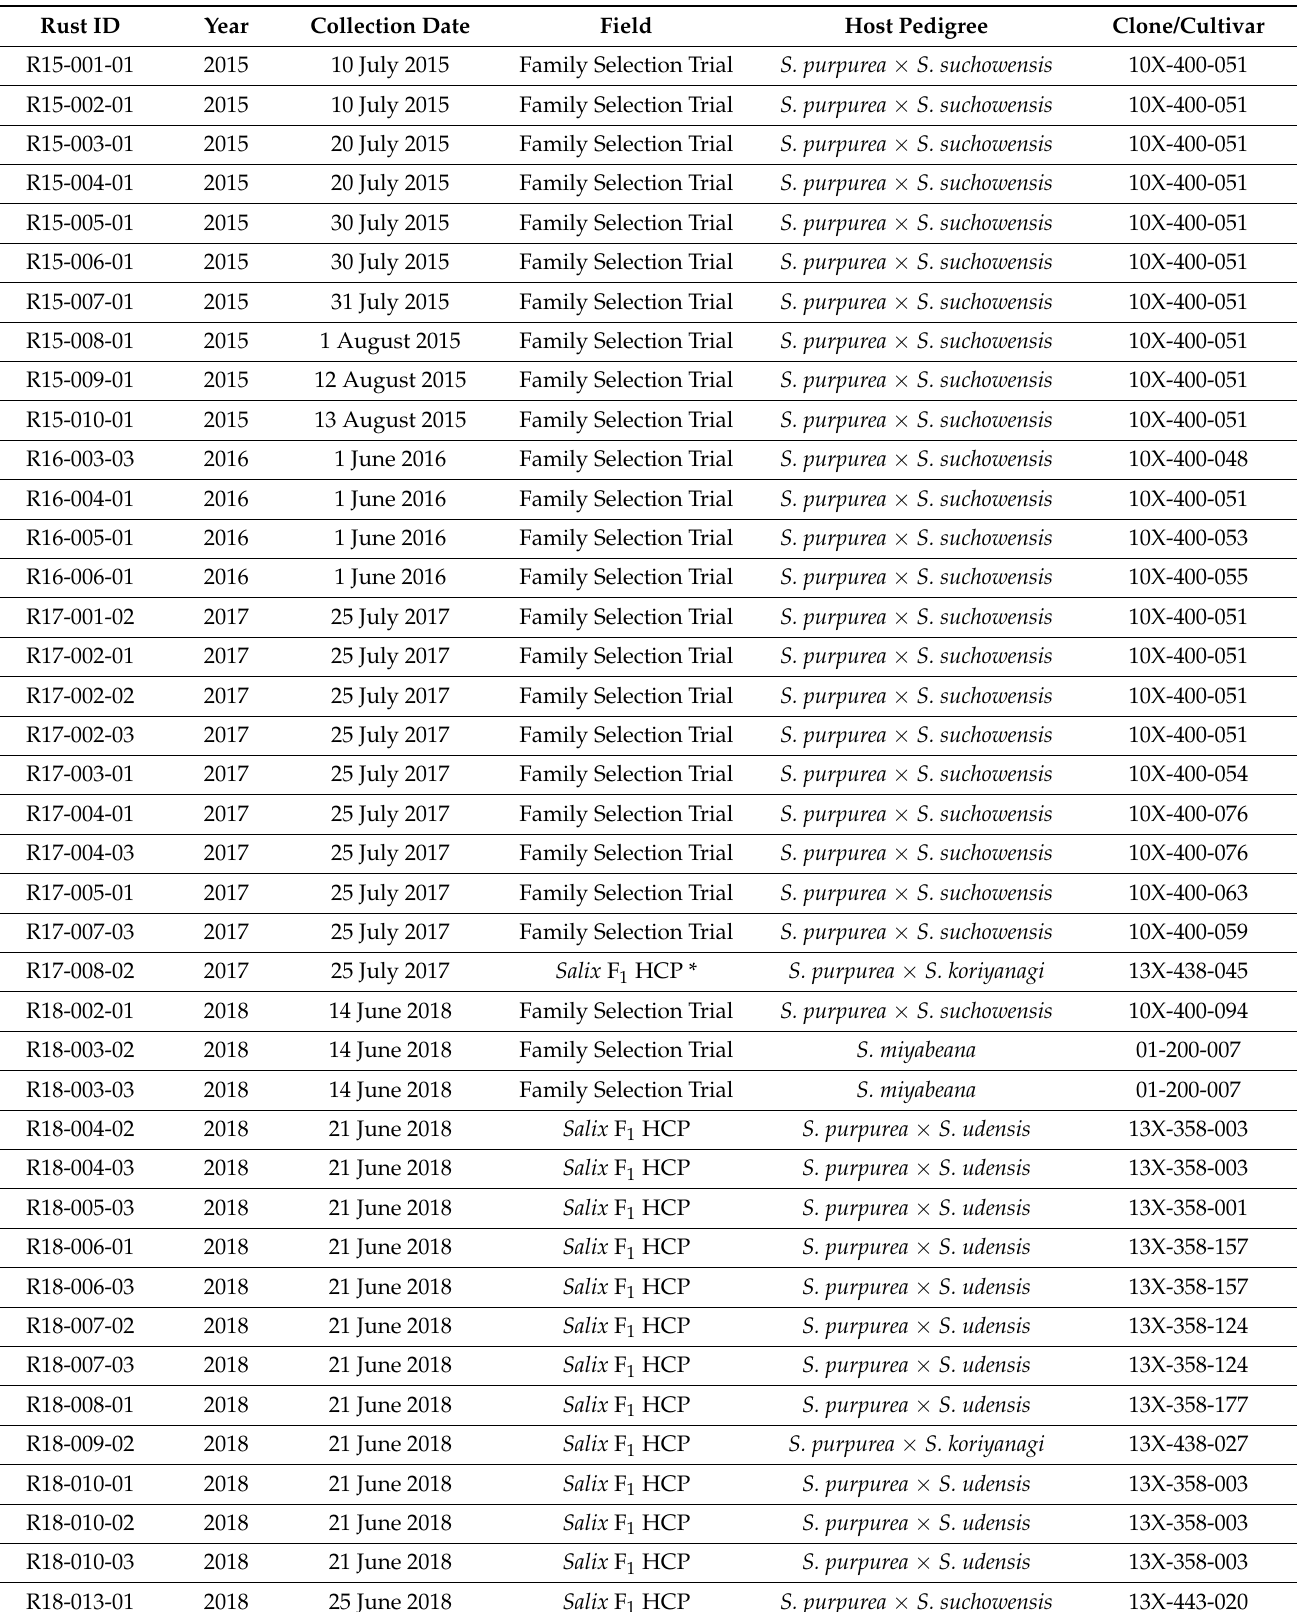
Table 1. Melampsora paradoxa isolate